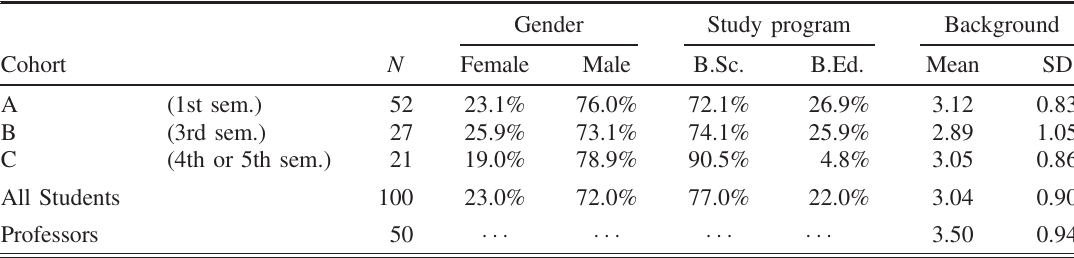
TABLE III. Sample overview. For each cohort, the full sample, and for the professors ’ sample from Ref. [10], we give the person count N , the percentage of persons giving “ female ” or “ male ” as their gender (participants could leave the question blank), the study program (numbers missing to 100% are due to missing answers), and the perceived background in NOS ( 1 ¼ “ much less than average ” to 5 ¼ “ much more than average ” compared to their respective